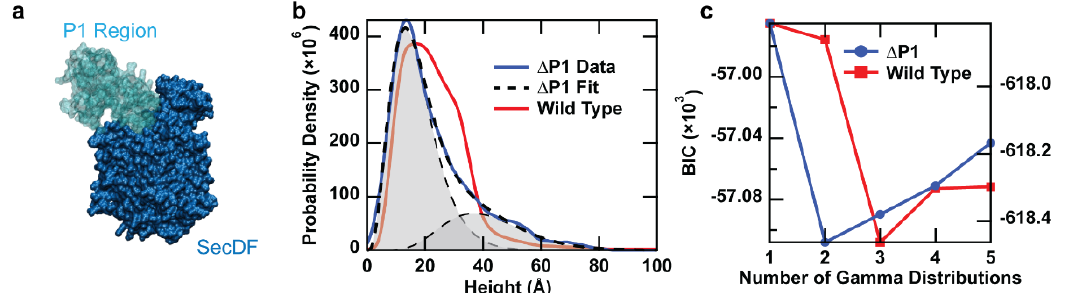
Figure 4. Mutagenesis of SecDF bolsters orientational assignment. ( a ) Structure of SecDF highlighting the P1 domain. The data is taken from a cryo-electron microscopy structure of the holotranslocon (5MG3). ( b ) Comparison of height distributions for the wild-type (red) and SecDF Δ P1 mutant ( N = 1490; blue). The overall shape of the distribution is altered significantly, and the number of distributions required to fit the data is decreased for the mutant. ( c ) BIC calculations for the optimal number of model distributions to fit the experimental data. Data are adapted from Ref. [40] .